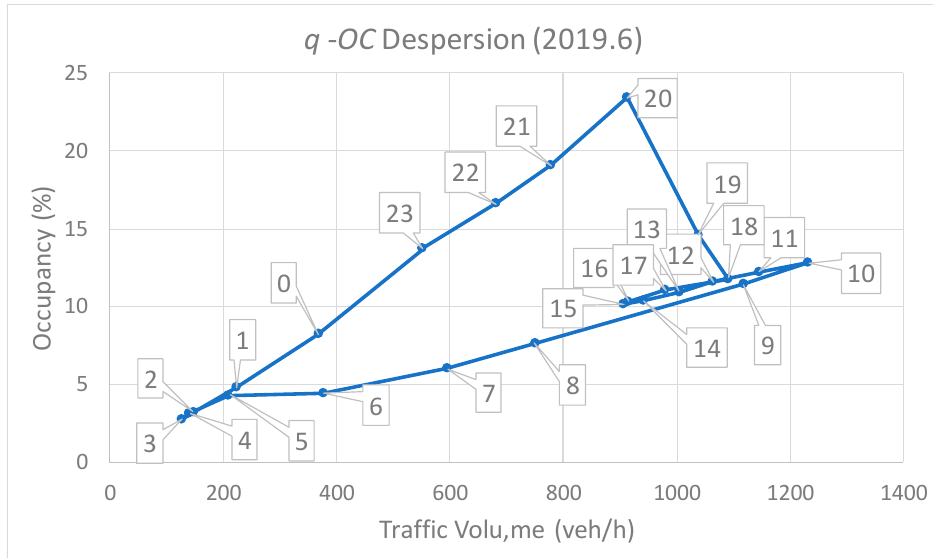
22:00. Figure 8 uses average traffic volume and occupancy data. To check real measure- ment data, actual measured data are plotted based on the time zone, which is divided into 6 time zones. F1 ranges from 00:00 to 03:59, F2 ranges from 04:00 to 07:59, F3 ranges from 08:00 to 11:59, F4 ranges from 12:00 to 15:59, F5 ranges from 16:00 to 19:59, and F6 ranges from 20:00 to 23:59. Figure 9 shows the time zone-based q – OC dispersion against Figure